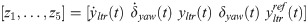
Critical regions.The generated critical regions of the eMPC controller can be seen in this figure, where [z1,…,z5]=[y˙ltr(t)δ˙yaw(t)yltr(t)δyaw(t)yltrref(t)]; 113 critical regions were formed based on the constraint set, of which 16 regions are feasible for obtaining an optimal control input when only z1 and z2 vary and the other parameters are fixed. Each region owns its unique sequence of optimal vectors, and the controller explicitly chooses a region based on the parameter values.